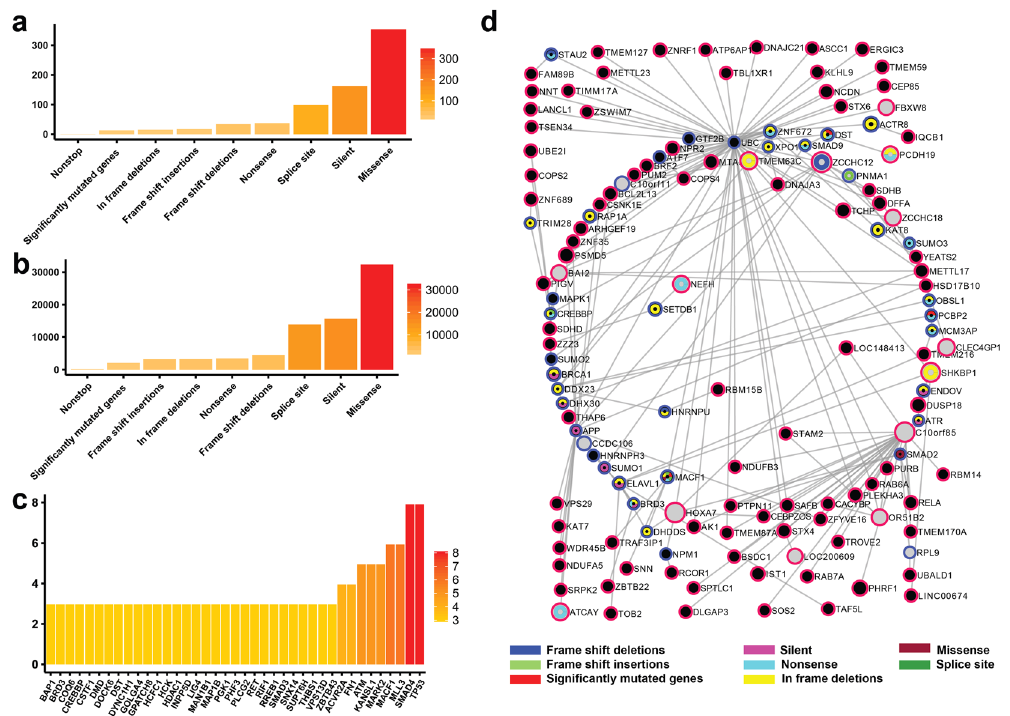
Figure 6. Reconstructed genetic landscape of pancreatic cancer PIE-MIN. The reconstructed pancreatic cancer PIE-MIN illustrates the ( a ) frequency of a given mutation type; ( b ) cumulative number of protein interacting partners by mutation type; ( c ) frequency of mapped genes showing at least three different mutation types; ( d ) Presence of cancer-related Class I and Class II